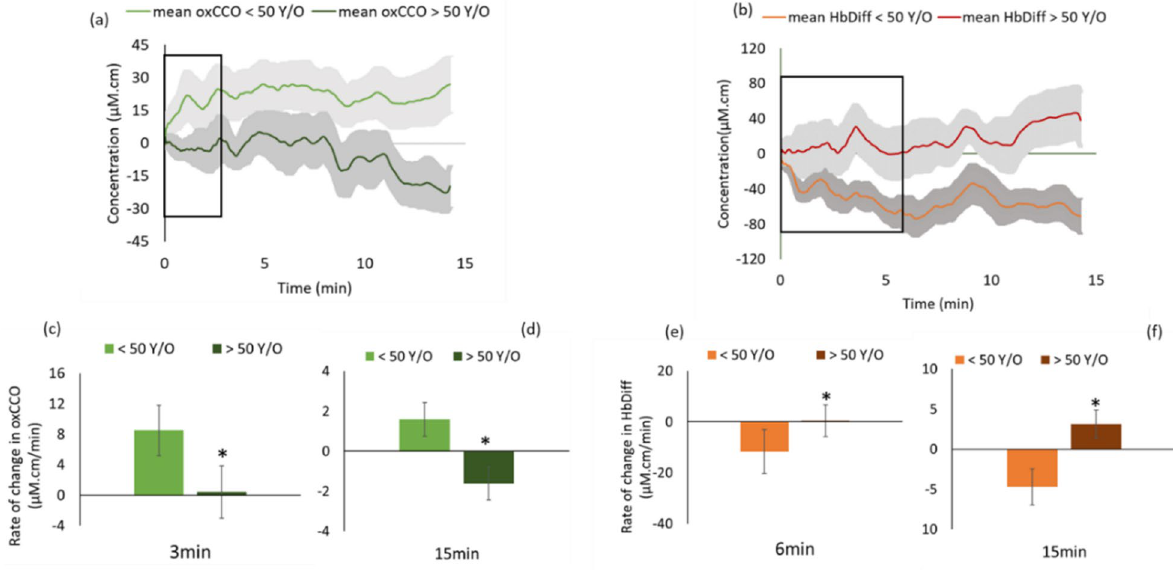
Figure 1. Retinal performance during dark adaptation is faster in subjects younger than 50 years old (y/o) compared to those older than 50 y/o. ( a ) Rate of oxidation of CCO in all subjects < 50 y/o is significantly greater than that for over 50 s as early as 3 min after dark onset. ( b ) Group data representing mean rate of oxidation of CCO in younger (n = 18) and older groups (n = 12). Oxidative metabolism is ~ 8 times higher in under 50 s within 3 min of dark adaptation. ( c ) Rate of change in retinal oxygenation (HbDiff = HbO 2 -HHb) is significantly greater in adults < 50 y/o during the first 6 min of dark adaptation (steeper gradient in < 50 y/o). Retinal oxygenation drops in in the younger subjects because of increased mitochondrial metabolism in dark as seen in ( a ), leading to increased O 2 uptake by the mitochondria hence increasing the amount of deoxygenated blood (HHb). In older subjects HbDiff is almost unchanged up to 6 min (corresponding to a stable oxCCO during the first 6 min in ( a ) and gradually builds up following a reduction in oxCCO ( a ). Solid lines in ( a,c ) are mean data for all the subjects in each group, N = 18 under 50 s and N = 12 over 50 s). Shaded areas in ( a,c ) are standard error from the mean. Pooled data are given for 3 and 15 min ( c–f ) for each metric. Error bars are standard error from the mean and asterisks signify statistical significance α <